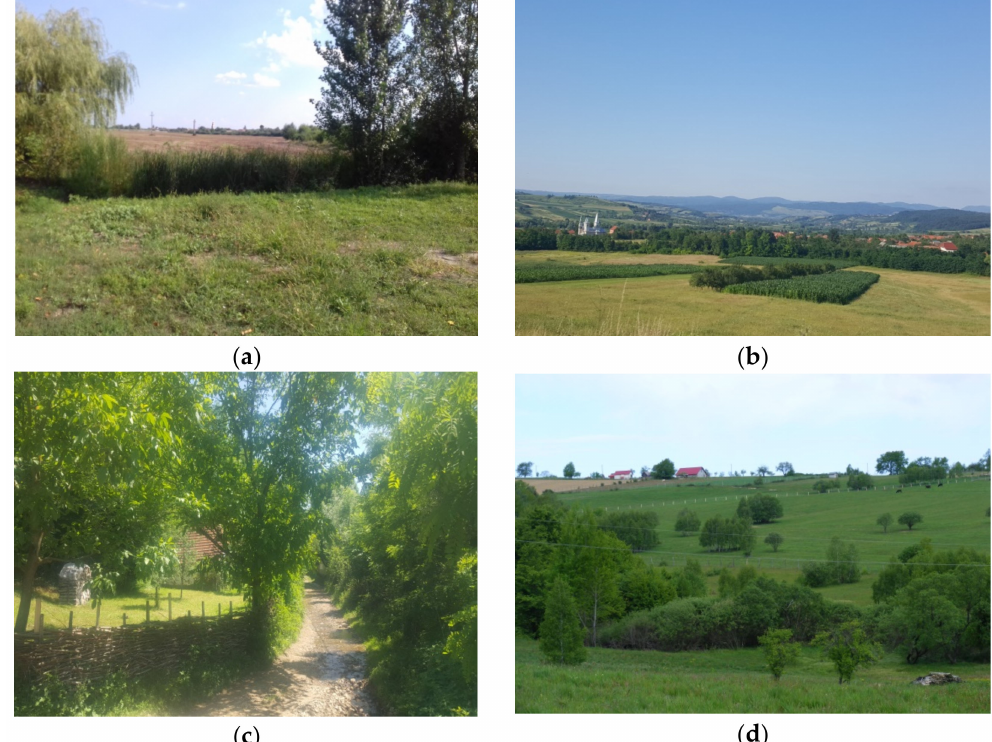
Figure 6. Exemplifying various types of environment in the studied area by showing the pervasive outlook and also the environment as a provider of human and animal life favorable conditions: ( a ) plains in the village of M ă d ă ras; ( b ) mixed hills-plains in the village of R ă b ă gani; ( c ) mixed hills-mountains in the village of Meziad; ( d ) mountain plateau in the village of S ,